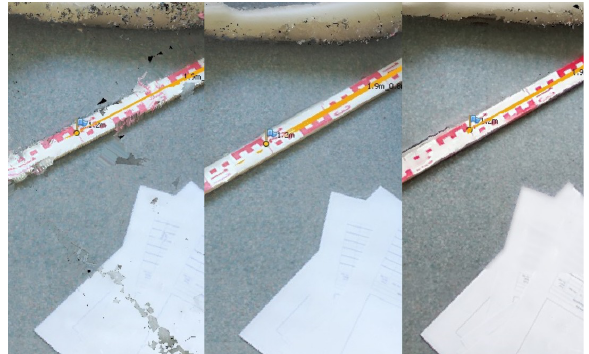
Figure 7. On the right, the fragmented texture of the high resolution images. In the middle the texture on the reduced resolution images. On the left the texture of the light field